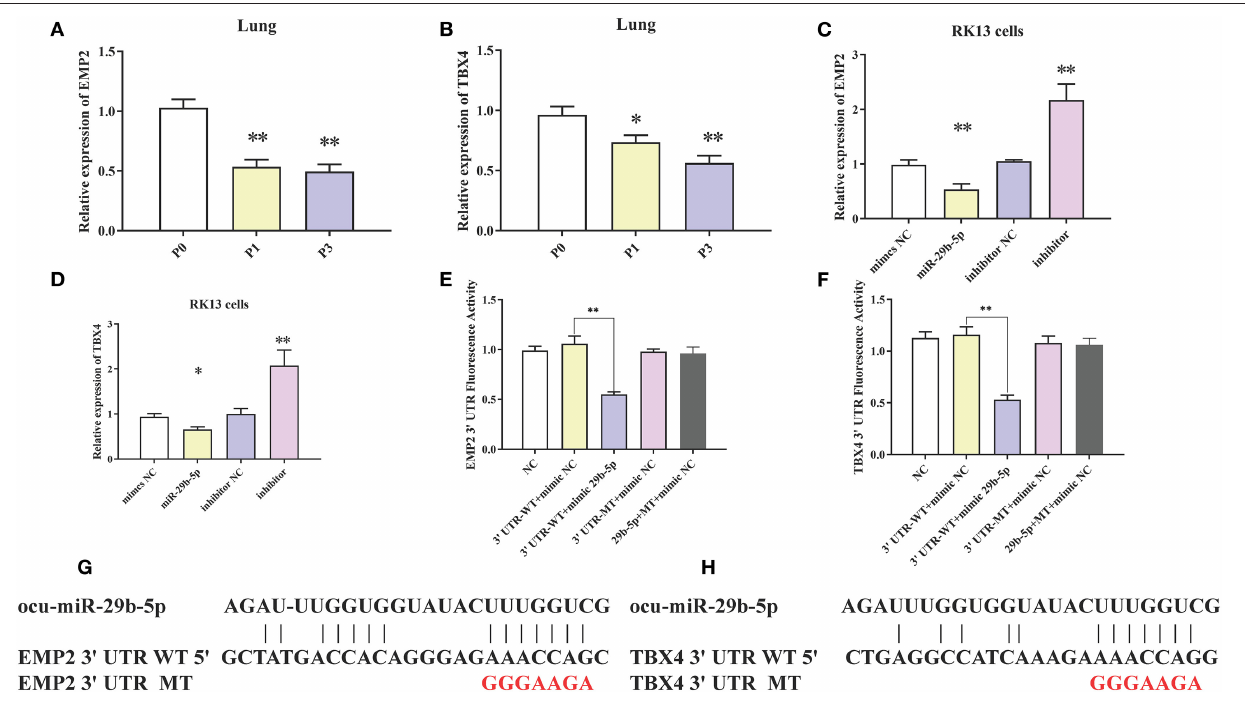
FIGURE 9 | Confirmation of EMP2 and TBX4 are direct targets of ocu-miR-29b-5p. EMP2 (A) and TBX4 (B) expression profiles in rabbit infected or uninfected lung samples. EMP2 (C) and TBX4 (D) expression profilers in RK13 cells transfected with ocu-miR-29b-5p mimics or knockdown of miR-29b-5p. Relative fluorescence activity of the luciferase constructs containing the wildtype or mutant 3 ′ UTR of EMP2 (E) and TBX4 (F) genes in RK13 cells with or without the ocu-miR-29b-5p mimic. Diagram of the potential ocu-miR-29b-5p binding site within the 3 ′ UTR of EMP2 (G) and TBX4 (H) (3 ′ UTR WT). The mutated 3 ′ UTR (3 ′ UTR MT) harbors a mutated region that could not complementary to the ocu-miR-29b-5p seed sequence (GGGAAGA). Values are shown as means ± SD. * P < 0.05, ** P <